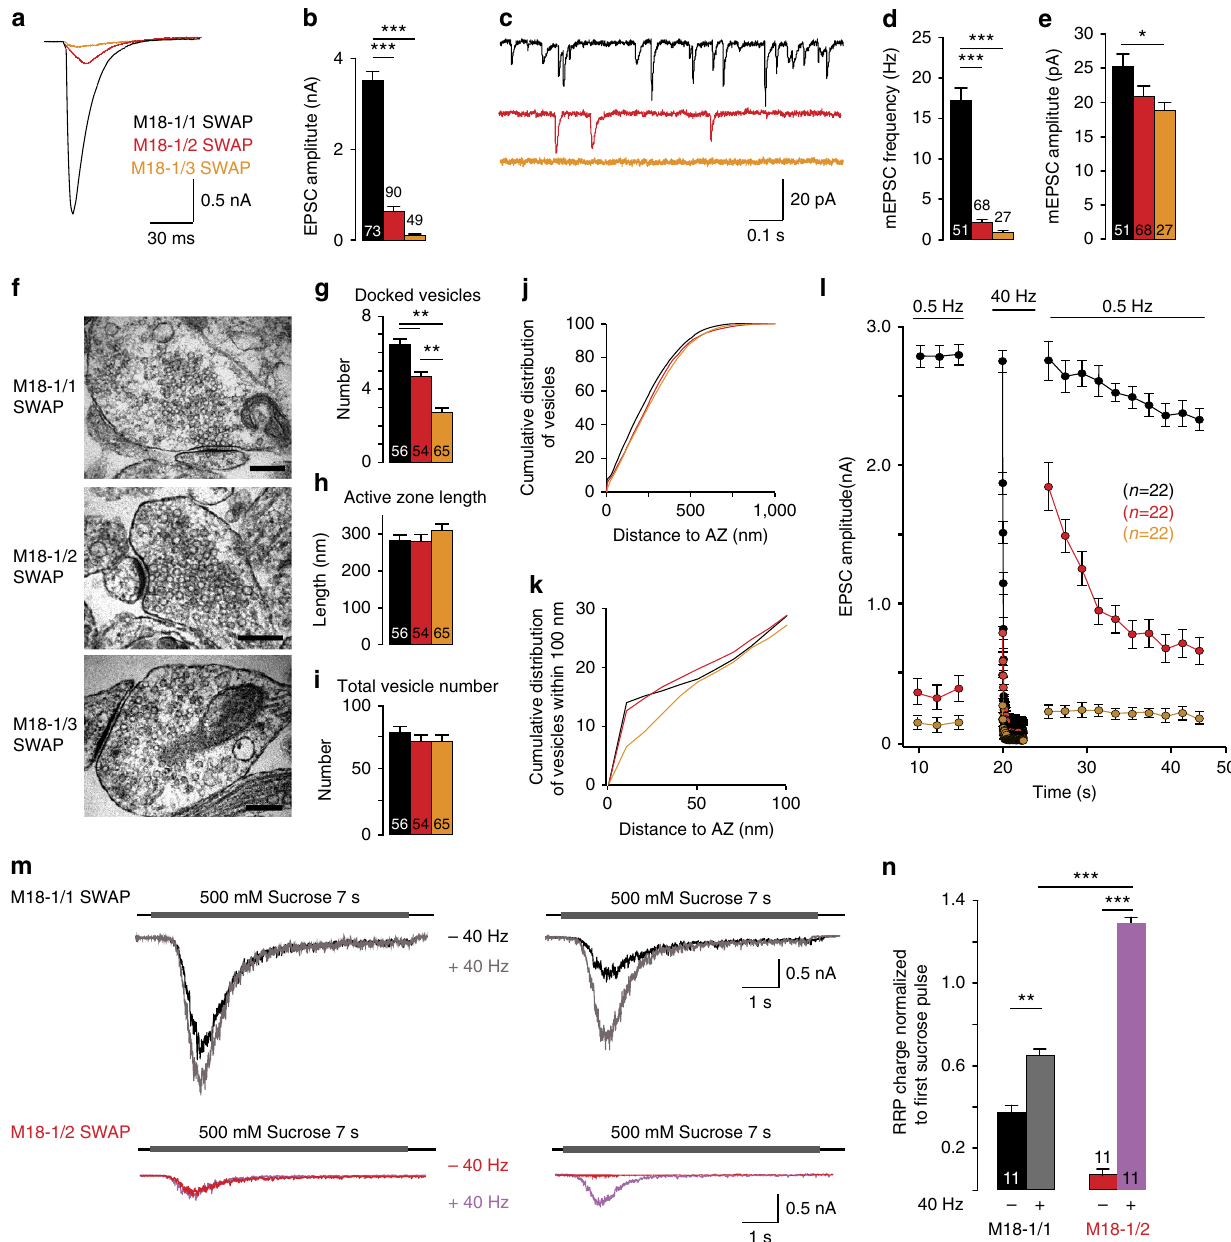
Figure 1 | Replacing Munc18-1 with Munc18-2 but not Munc18-3 produces a munc13-1 null phenocopy. ( a , b ) Sample traces and quantification of evoked EPSCs in naive munc18-1/1SWAP, munc18-1/2SWAP and munc18-1/3SWAP neurons. ( c – e ) Mini EPSCs sample traces ( c ), and quantification of frequency ( d ) and amplitudes ( e ). ( f – k ) Ultrastructural analysis of munc18-1/1SWAP, munc18-1/2SWAP and munc18-1/3SWAP asymmetric (glutamatergic) synapses: sample electron micrographs; scale bar,100nm, ( f ) and quantification of docked vesicles ( g ), active zone length ( h ) and total vesicle number ( i ); cumulative plot of vesicle distance from the active zone ( j ) and a zoom of the first 100nm ( k ). ( l ) Synaptic run down during 100AP at 40Hz and transient potentiation of synaptic transmission in munc18-1/2SWAP , but not the other genotypes. ( m , n ) Assessment of activity-dependent priming using application of hypertonic sucrose to probe the readily releasable vesicle pool: sample traces (m) of munc18-1/2SWAP (red/blue) and control ( munc18-1/1SWAP , black/grey) neurons stimulated with 500mM sucrose twice with a 3s interval with (grey/bleu) or without (black/red) 100AP at 40Hz during this interval; ( n ) quantification of total charge generated by second hypertonic sucrose pulses, normalized to the first pulse. All data in this figure are means ± s.e.m.; * P o 0.05, ** P o 0.01, *** P o 0.001 as determined by ANOVA. See Supplementary Table 1 for all values, s.e.m. and n -numbers plotted in this figure. ANOVA, analysis of variance.